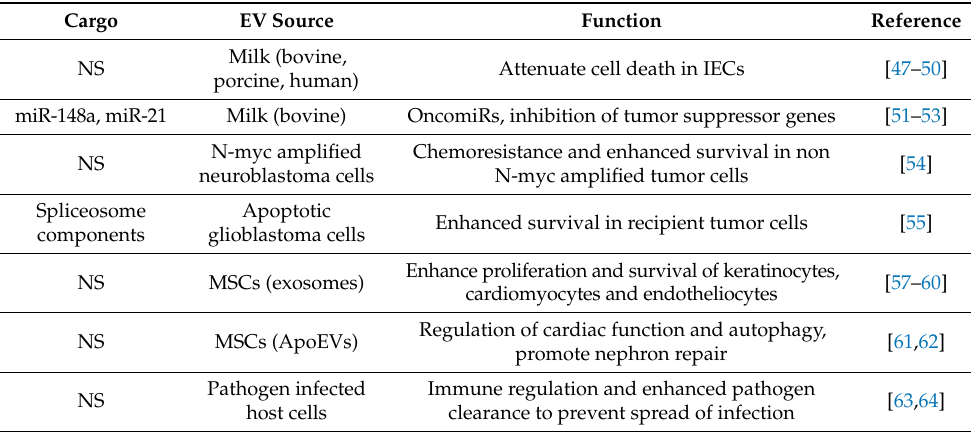
Table 1. Table summarizing the studies which elucidate the role of EVs in attenuation of cell death. NS—not specified in the original